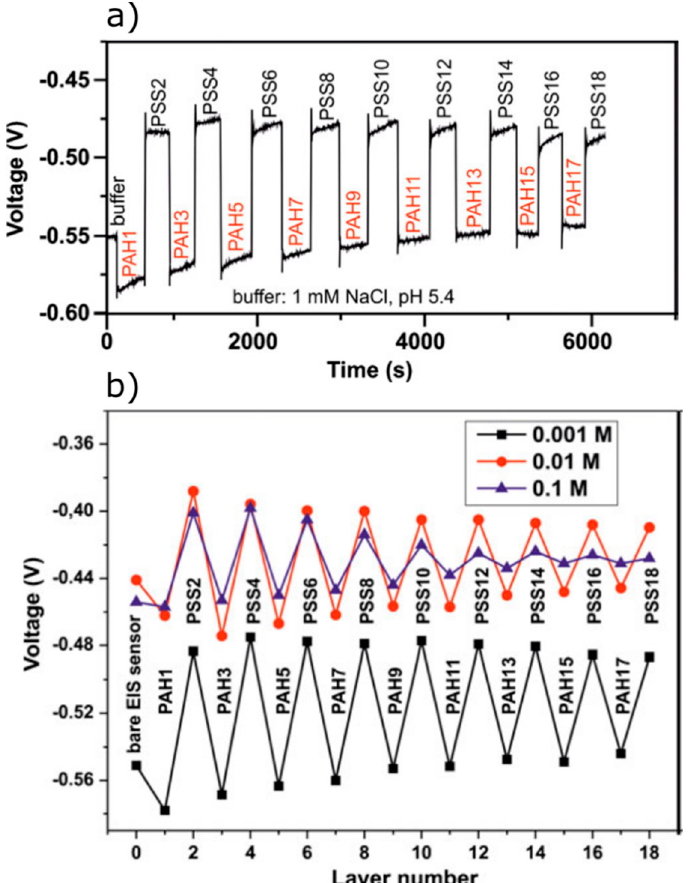
Figure 6. Electrical monitoring of the PE multilayer build-up with a p-Si–SiO 2 EIS sensor. ( a ) ConCap response and ( b ) potential shifts as a function of the PE layer number and ion concentration. The PAH and poly(sodium 4-styrenesulfonate) (PSS) layers were deposited from a 50 µM PE solution adjusted with different NaCl concentrations of 100, 10, and 1 mM (pH 5.4). Reproduced from Ref. [172] with permission from Springer.